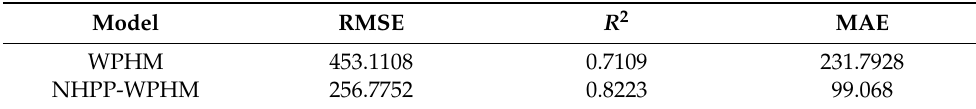
Table 10. RMSE, R 2 , and MAE before the second repair.